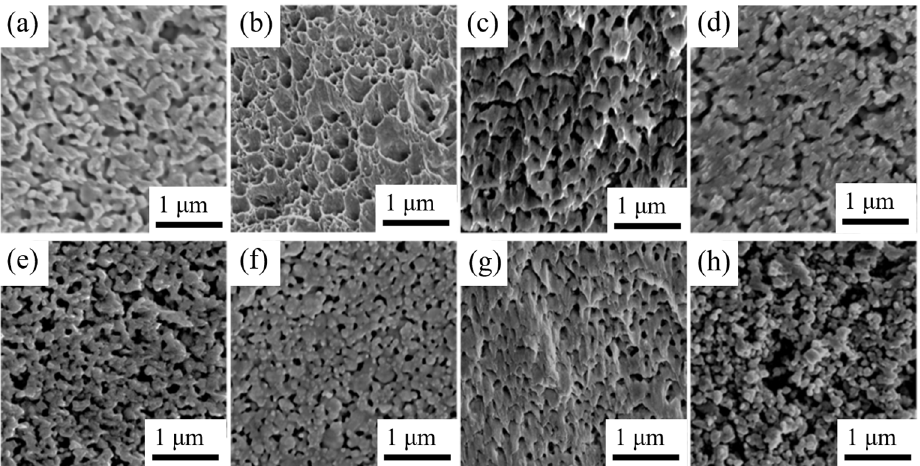
Figure 13. The fracture structures of different Ag sintering joints: ( a ) Ag/MOD1, ( b ) Ag/MOD2, ( c ) Ag/MOD3, ( d ) Ag/MOD4, ( e ) Ag/MOD5, ( f ) Ag/MOD6, ( g ) Ag/MOD7, ( h ) Ag.